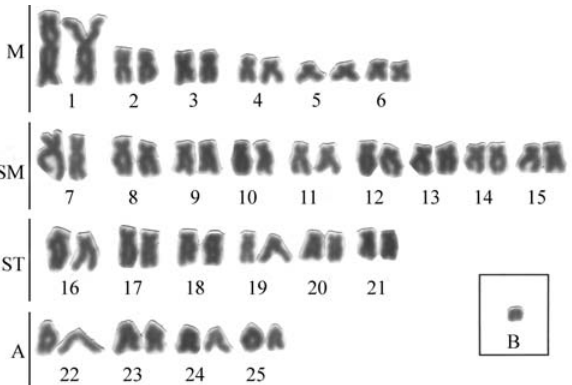
Figure 1 - Giemsa-stained karyotype of Astyanax altiparanae from the Campo Novo River. In evidence, one supernumerary chromosome.